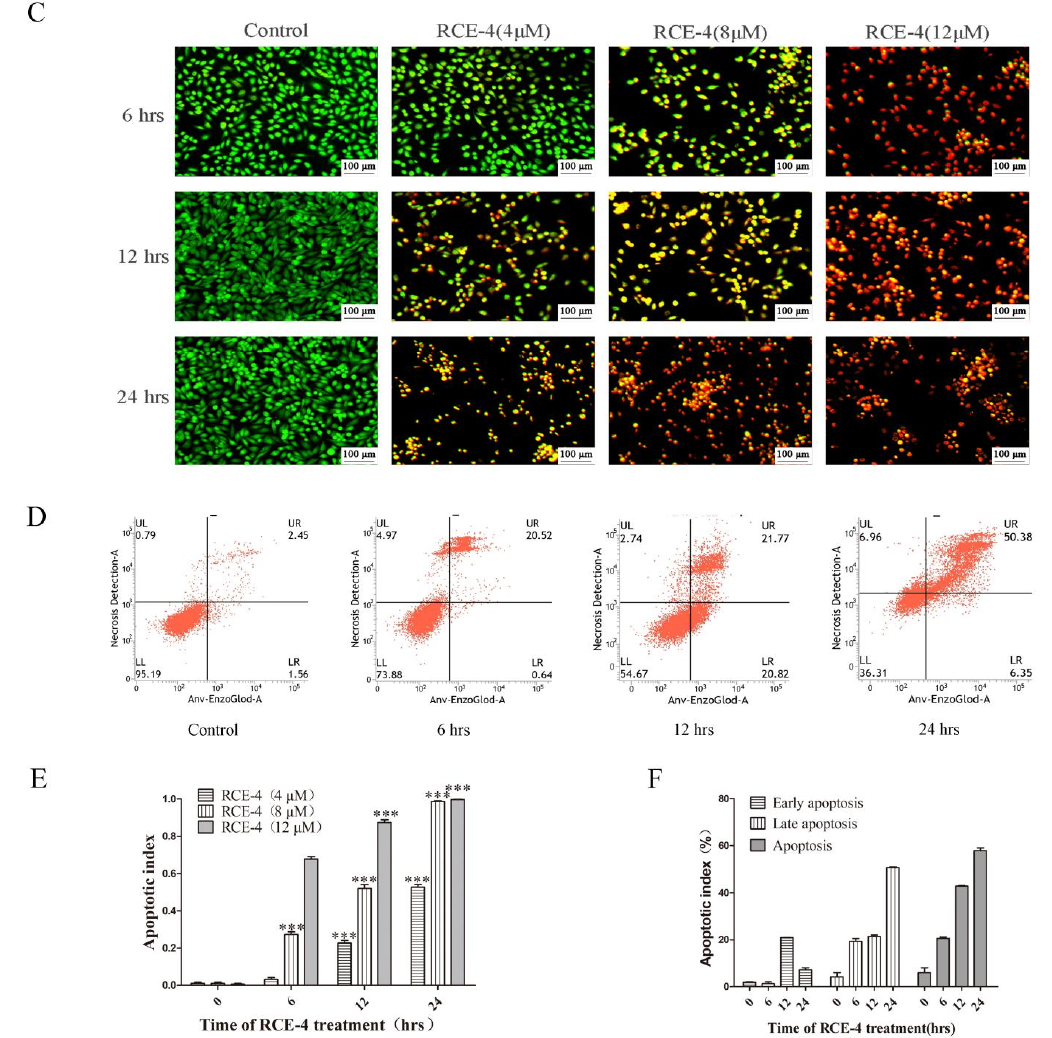
Figure 2. RCE-4 induces time- and concentration-dependent apoptosis and autophagy in Ca Ski cells. ( A ) The protein expression levels of apoptosis associated proteins in Ca Ski cells treated with RCE-4 at different times was analyzed by western blotting. β-actin was used as the loading control. ( B ) Densitometry analysis of the expression of proteins. ( C ) and ( E ) AO/EB Staining was used to detect apoptosis in Ca Ski cells. Scale bar: 100 µ M. Viable cells, bright green chromatin with organized structure; viable apoptotic cells, bright green chromatin, which is highly condensed or fragmented; non-apoptotic nonviable cells, bright orange chromatin with organized structure; nonviable apoptotic cells, bright orange chromatin, which is highly condensed or fragmented. Data are presented as the mean ± standard deviation of three independent experiments. ( D , F ) Ca Ski cells were treated with RCE-4 for 24 h, and apoptosis was detected by flow cytometry. Data are presented as the mean ± standard deviation of three independent repeats, *** p < 0.001 vs. Control. AO, acridine orange.